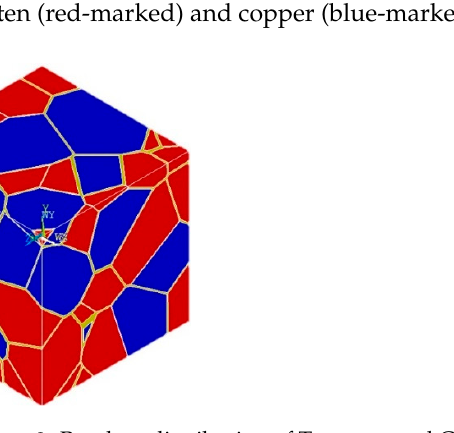
Figure 9. Random distribution of Tungsten and Copper grains. Table 4. Material properties used in the simulations, data from [30–33].